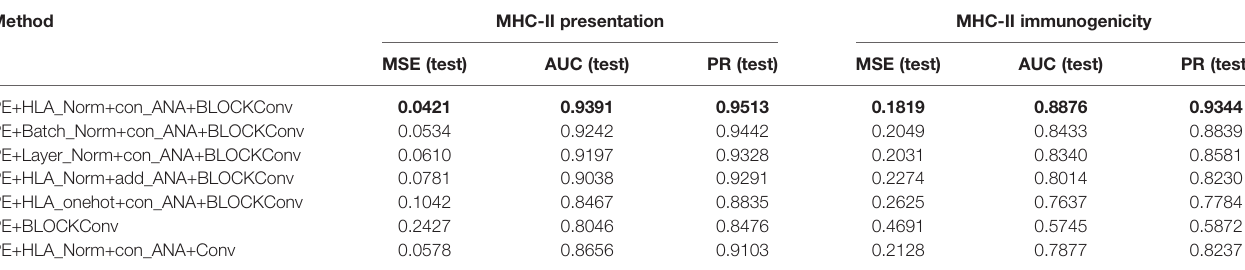
TABLE 1 | Results of the ablation experiment. MSE (mean-squared error), AUC (area under the curve), and PR (precision rate) are evaluation indicators.